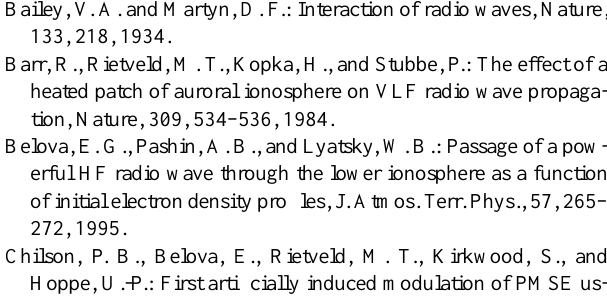
Fig. 5 results. High variance is also present at the lowest measured altitudes due to the weak backscattered